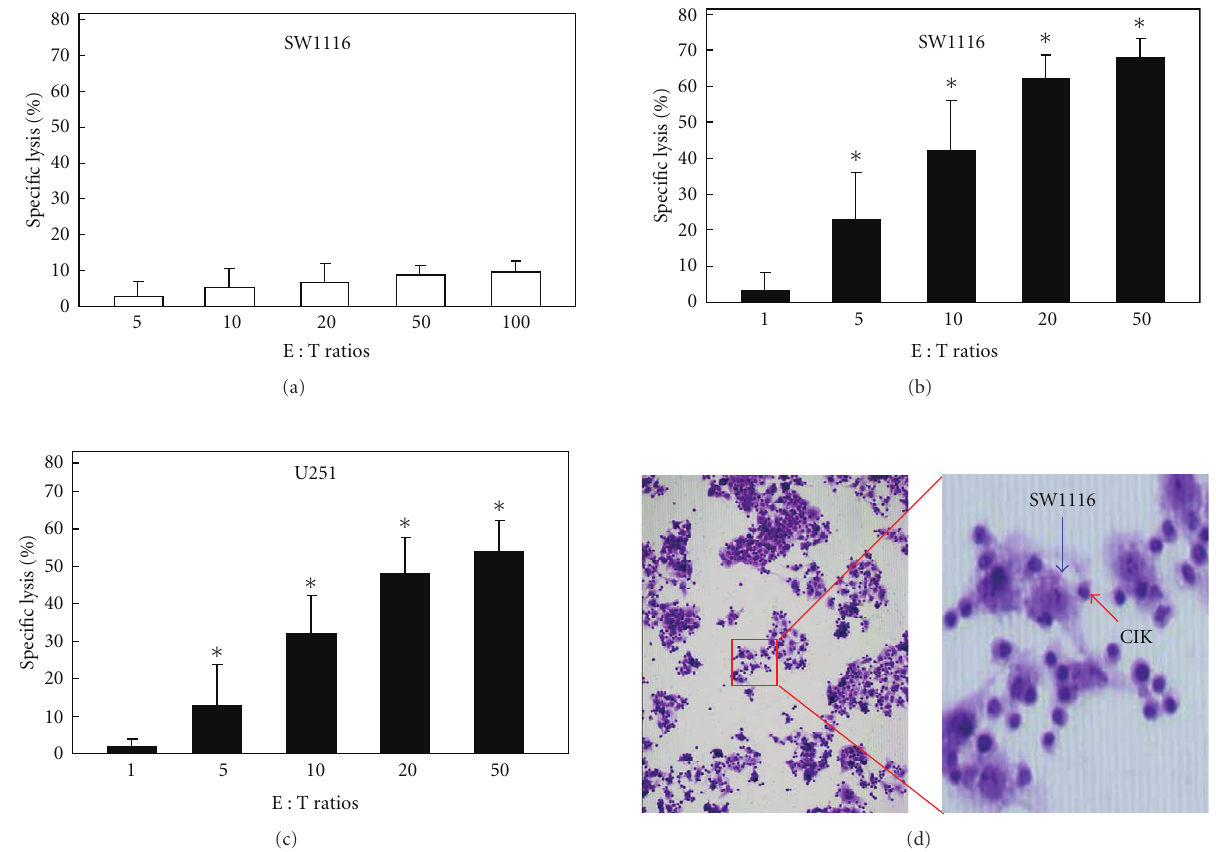
Figure 2: Cytotoxicity of CIK cells in vitro. (a) Cytotoxicity of PBMCs against SW1116 cells. (b) Cytotoxicity of CIK cells against SW1116 cells. (c) Cytotoxicity of CIK cells against U251 cells. At an e ff ector :target ratio of 100: 1, the percentage lysis of SW1116 cells after the addition of PBMCs was 9%. At e ff ector :target ratios of 1:1, 5:1, 10:1, 20: 1, and 50 :1, the percentage lysis after the addition of CIK cells was 3%, 23%, 42%, 62%, and 68%, respectively, for SW1116 cells and 2%, 13%, 32%, 48%, and 54%, respectively, for U251 cells. (d) Observation of the distribution of CIK cells by HE staining, × 100 and × 200. CIK cells adsorbed to and aggregated around the SW1116 cells. For cytotoxic assay, each experiment was performed in triplicate and was repeated at least three times, and the results are expressed as mean ± SD. ( ∗ P < .